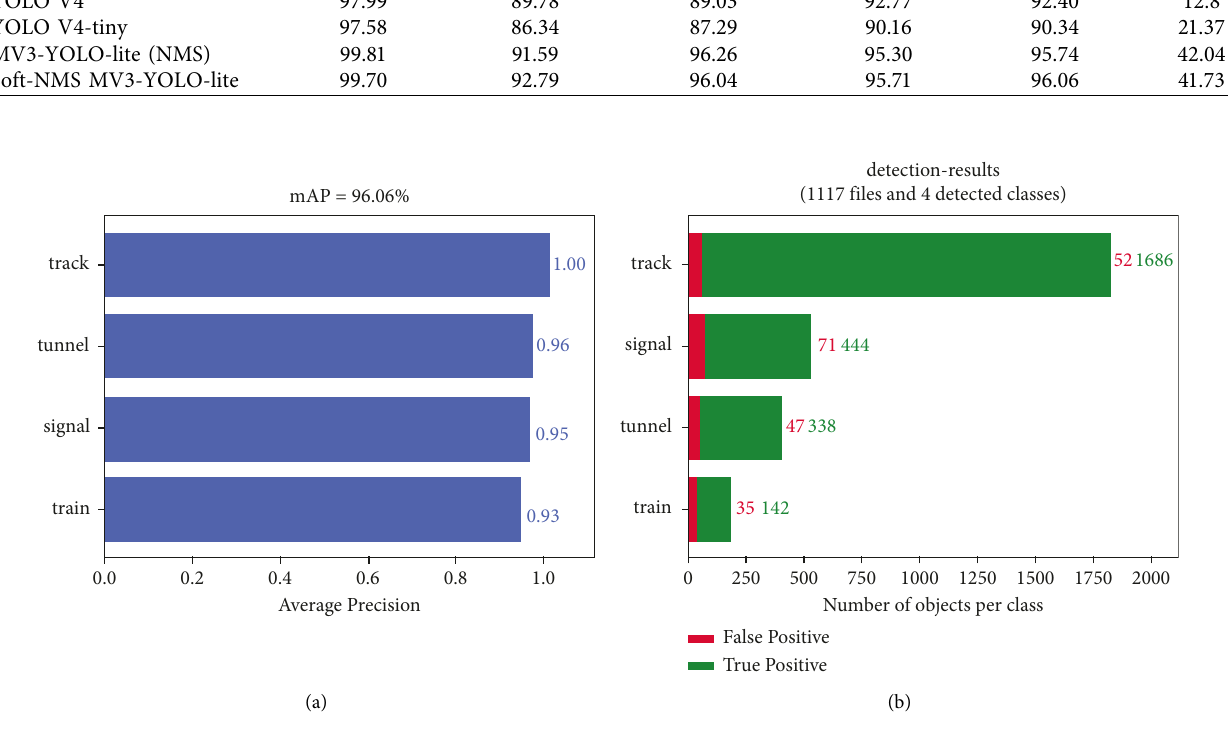
algorithm on the test set and the prediction results of various targets are shown in Figure 13.